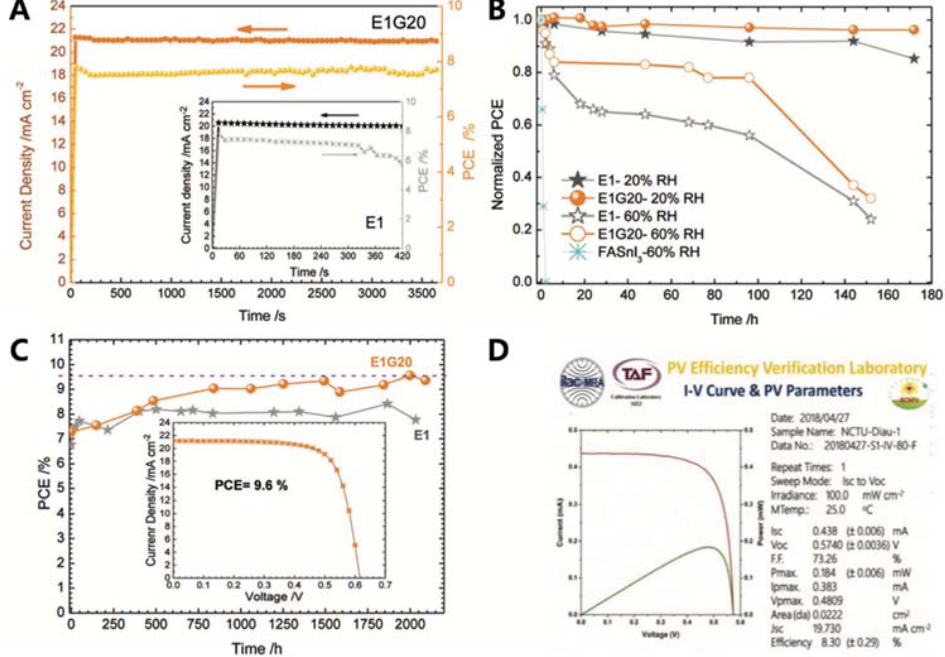
Figure 4. ( A ) Stabilised efficiency of power conversion and photocurrent density of two different devices tested in different environments. The measurement was taken at the position of maximum power for 1 sun irradiation with an AM1.5G solar simulator for 3600 s. Device reliability test conducted in ( B ) ambient air with relative humidity = 20% and 60% without encapsulation and ( C ) in N 2 -filled glove box. ( D ) Efficiency of 8.30%, certified by ISO-approved PV Efficiency Verification Laboratory in Taiwan. Reprinted with permission from ref. [38] Copyright 2018, the John Wiley and Sons.